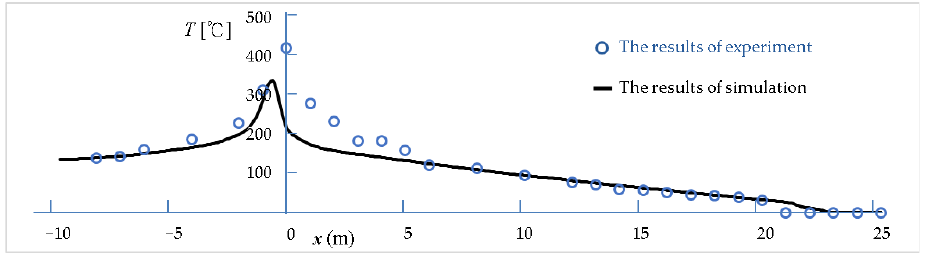
Figure 9. The temperature distribution experiment’s result in the x -direction compared with the results of the simulation model; z = 0.98 m, Q m = 161 kW, U m = 0.421 m/s, t = 200 to 260 s.